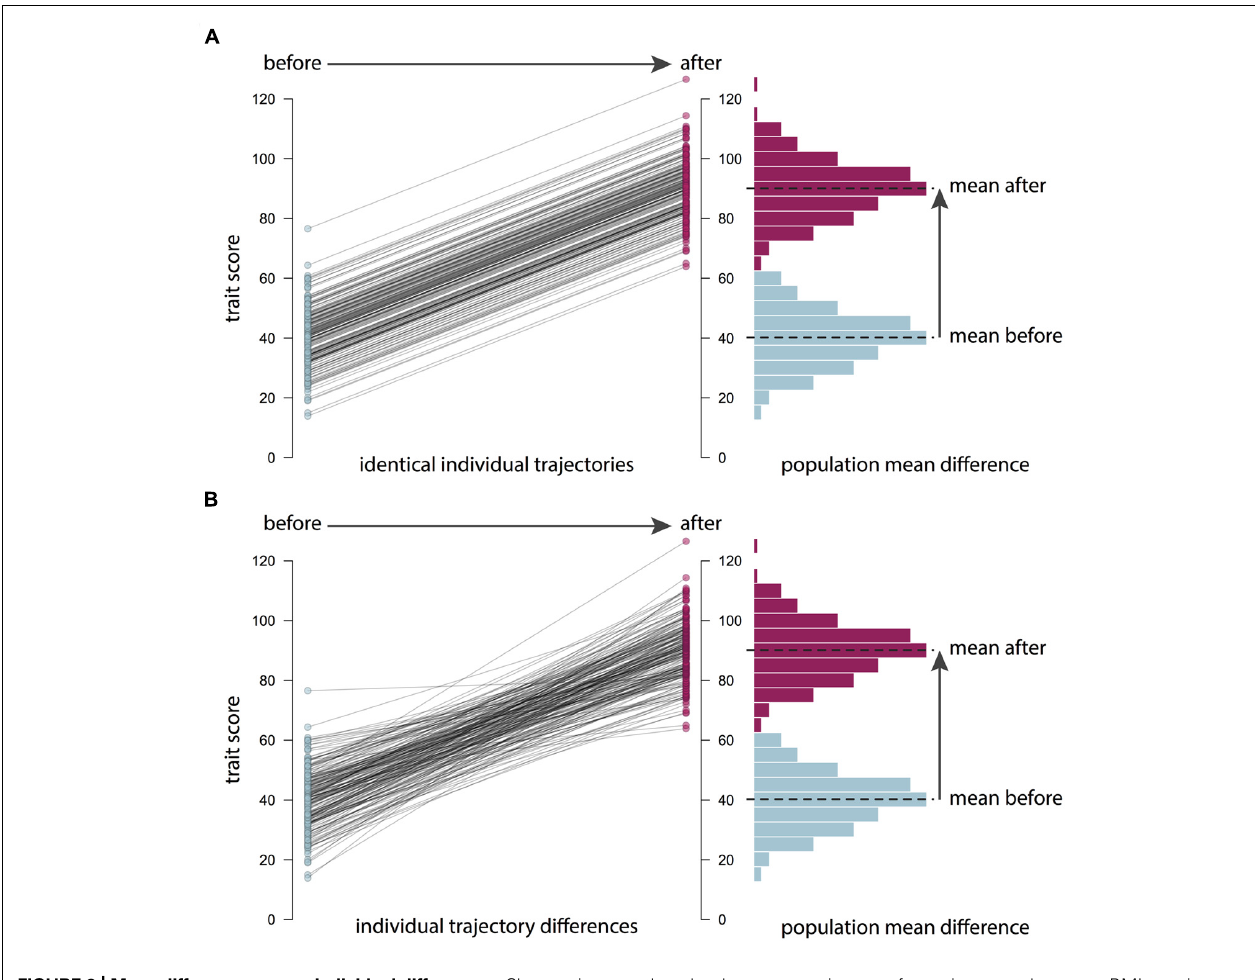
FIGURE 2 | Mean differences versus individual differences. Changes in the population or sample mean do not necessarily imply changes in individual differences. For example, in (A) , an intervention or another environmental change leads to an increase in the mean trait score in a population of 200 individuals: the whole distribution is shifted, as shown in the histogram on the right. However, the plot on the left shows that the trajectories of the individuals in the population are identical, so individual differences statistics, such as the heritability of the trait, are unaffected.This is the situation with the recent increase in body mass index (BMI) in many countries: even though